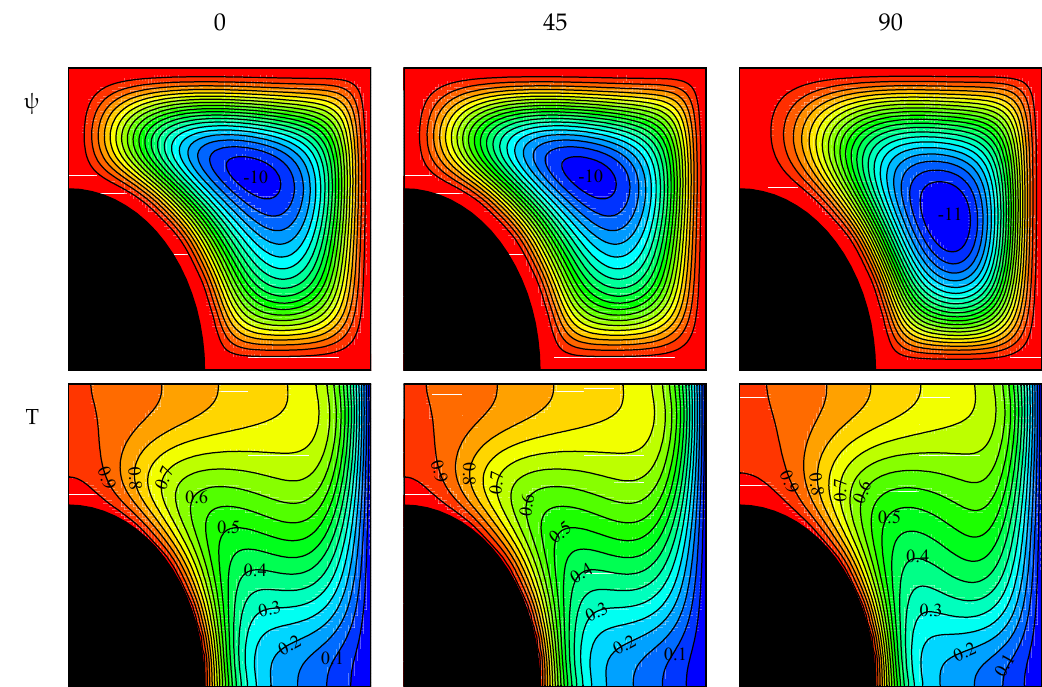
Figure 9. Stream and isothermal lines for Ra = 10 5 , Rd = 1, Ha = 20, AR = 0.45 − 0.6, ω = 0, ϕ = 0.03, and various MGF